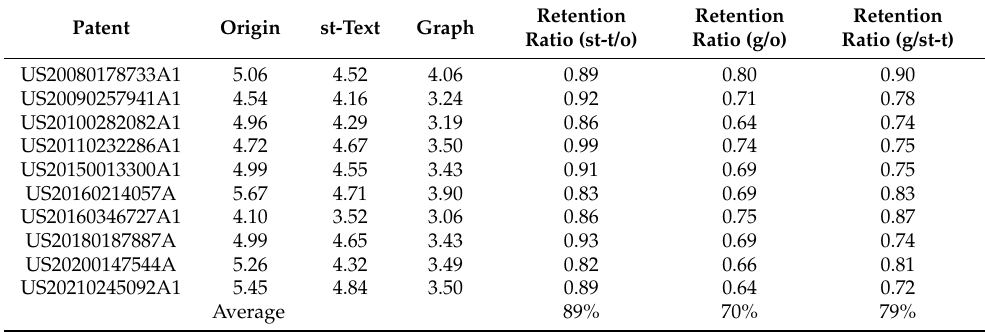
Table 5. Cluster 5 validation